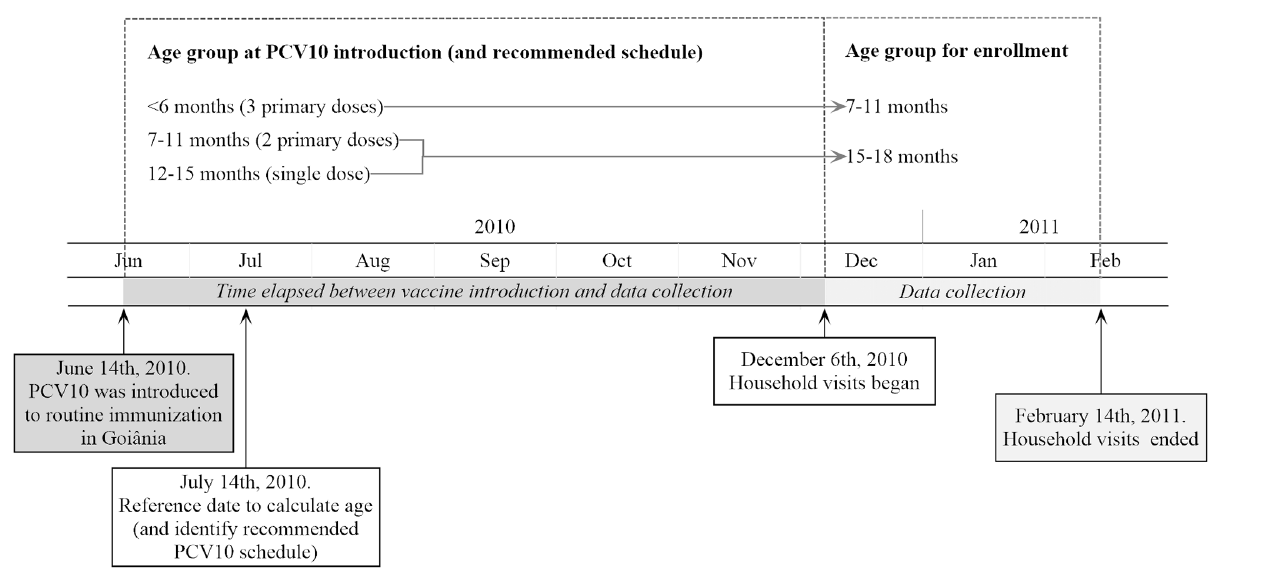
Fig 1. From PCV10 introduction to household visits: a timeline of study